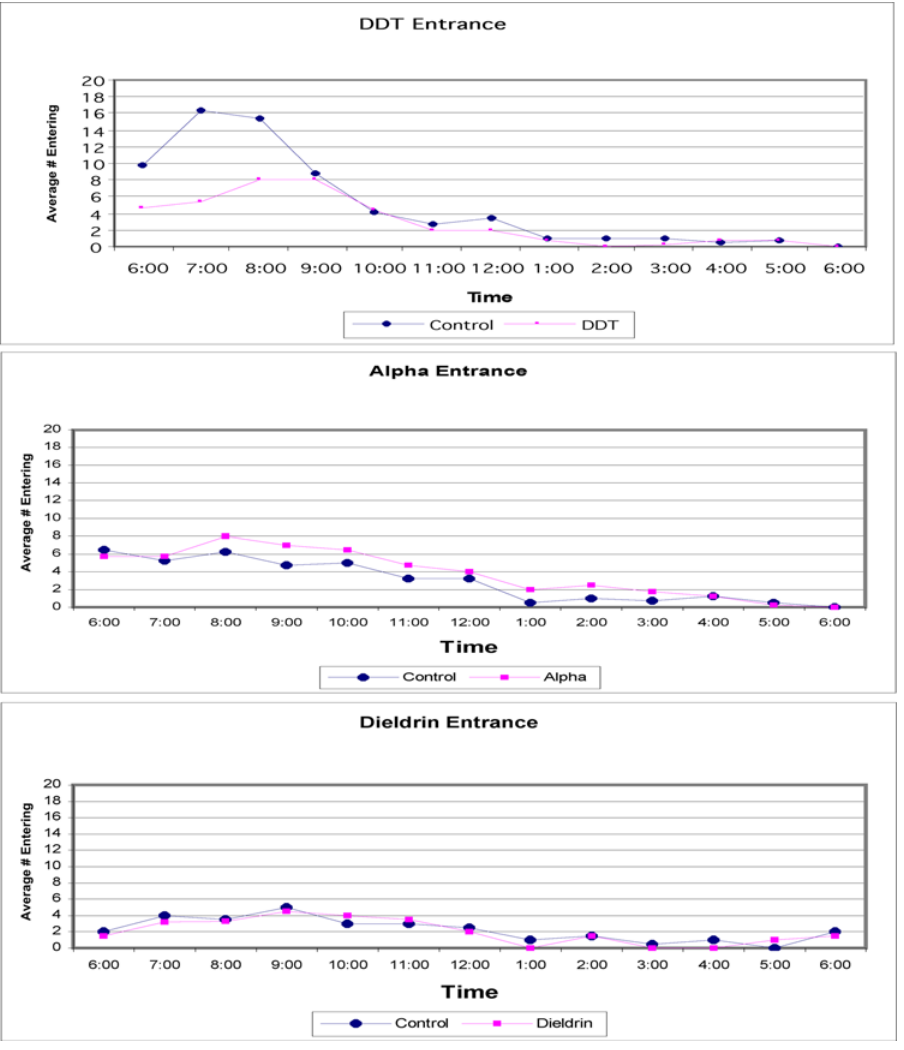
Figure 3. Entering Ae.aegyptiby time for treated and matched control huts using DDT, alphacypermethrin and dieldrin.